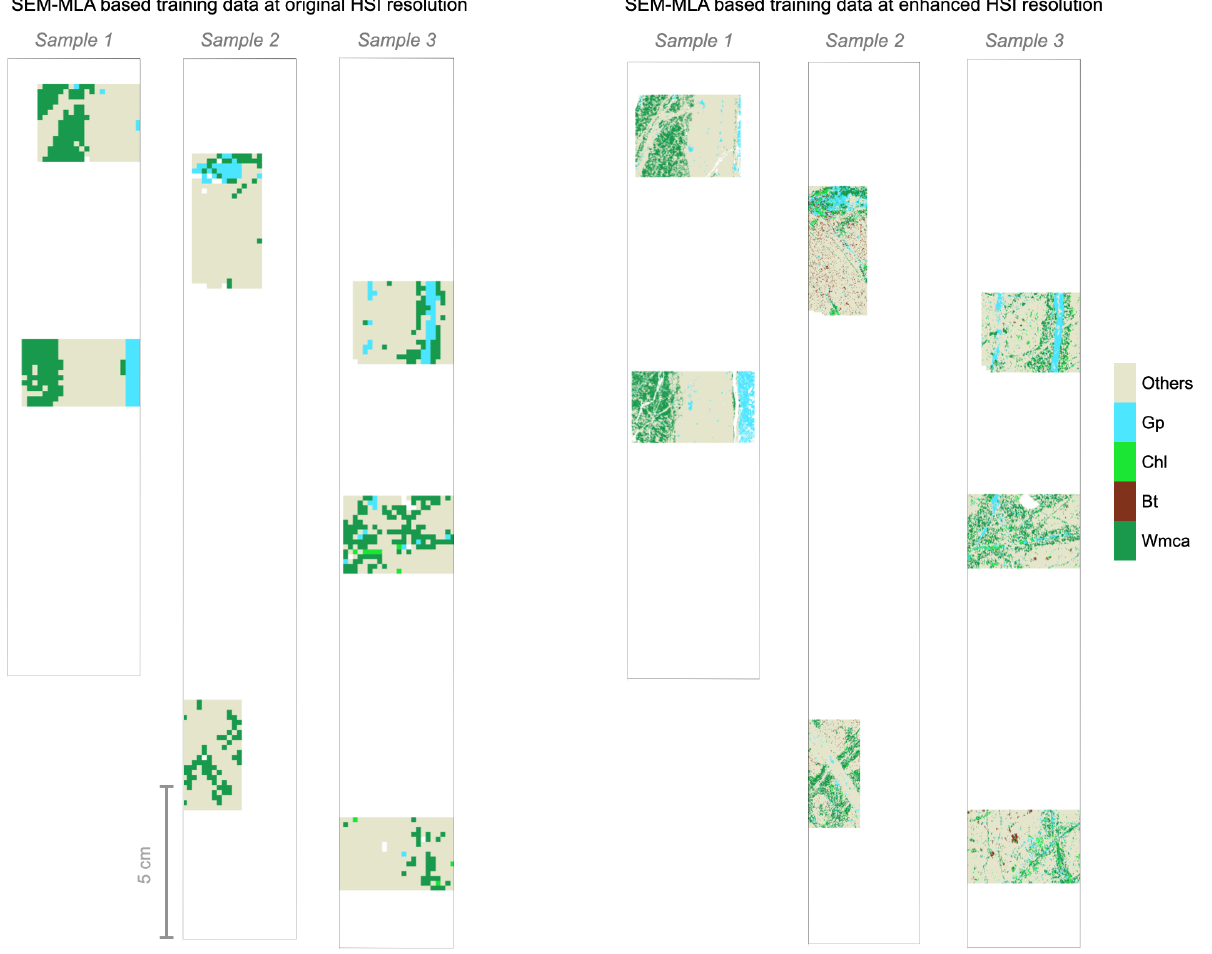
Figure 8. Co-registered scanning electron microscopy—mineral liberation analysis (SEM-MLA) images and resampled to the original hyperspectral (HSI) resolution (1.5 mm GSD) and to the resolution of the enhanced HSI data (0.1 mm GSD). (Wmca—white mica, Bt—biotite, Chl—chlorite, and